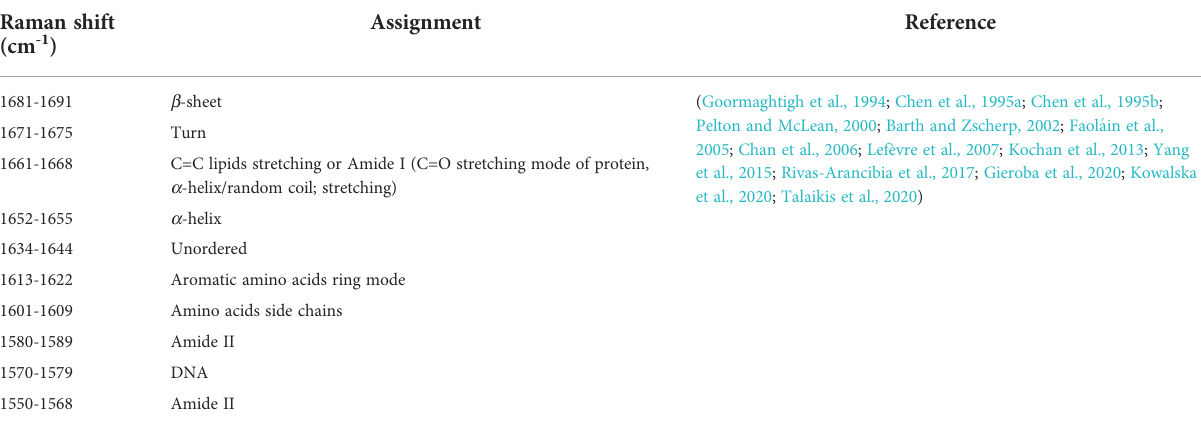
TABLE 2 Location of the Raman bands in the range of 1,550-1,700 cm -1 , and their assignments for the gills. Raman shift (cm -1 )